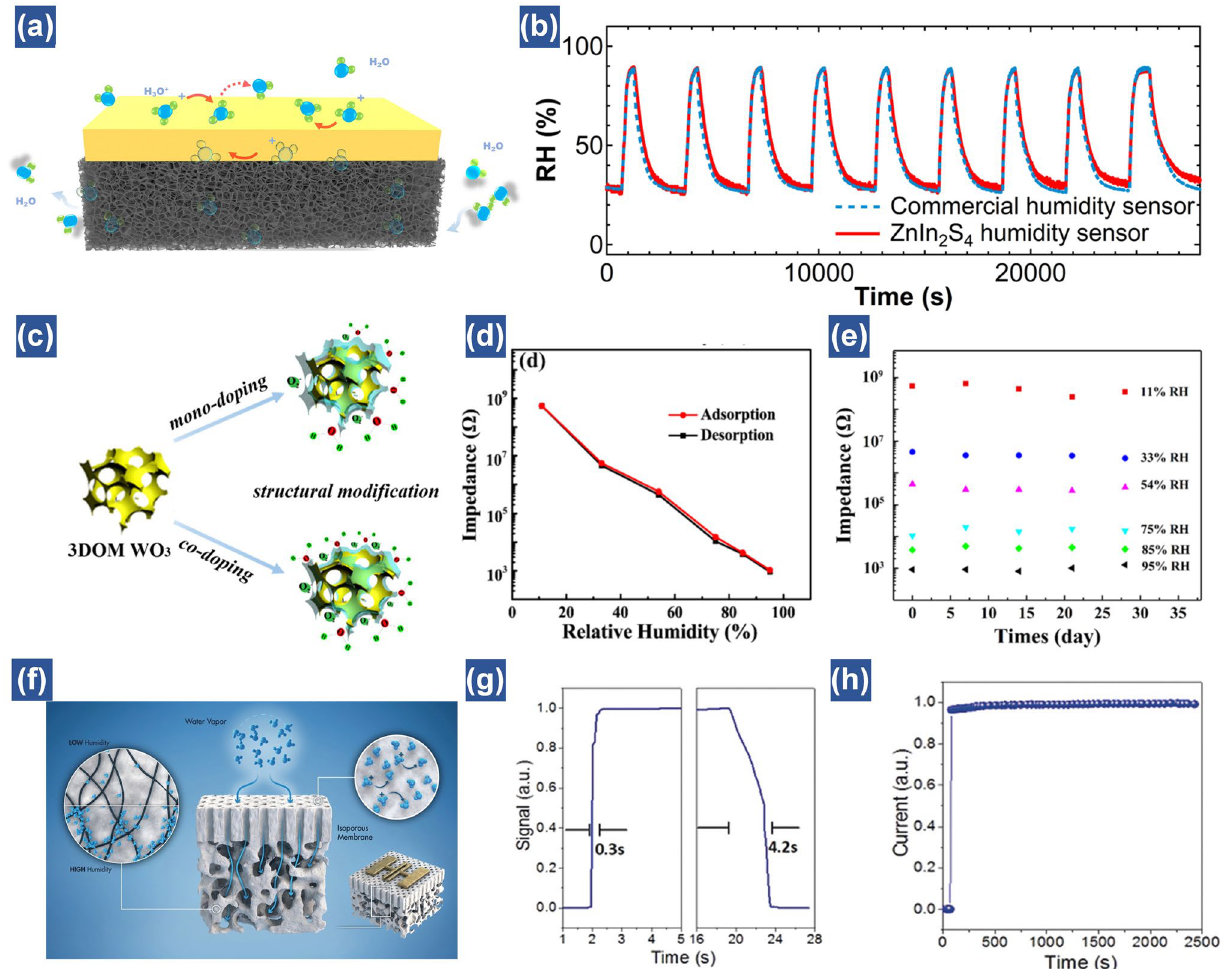
Fig. 8 Performance enhancement via structural design. ( a ) ZnIn 2 S 4 humidity sensor based on LIG porous substrates. ( b ) Long-time cycle meas- urement results of humidity using a commercial humidity sensor and the proposed humidity sensor in the oven under humidity variations from 30 to 90% [44]. Copyright 2020 ACS Publications. ( c ) Porous structure of Li/K-codoped 3DOM WO 3 . ( d ) The hysteresis plot of the codoped sample. ( e ) Stability of the Li/K-codoped sample [42]. Copyright 2018 ACS Publications. ( f ) Illustration of the sensing mechanism of the CNT- PS-b-P4VP film-based humidity sensor. ( g ) Transient response at 95% RH for carbon nantube-polystyrene-b-poly(4-vinyl pyridine) (CNT-PS-b- P4VP). ( h ) Stability of the CNT-PS-b-P4VP sensor under prolonged humidity (95%) exposure [45]. Copyright 2018